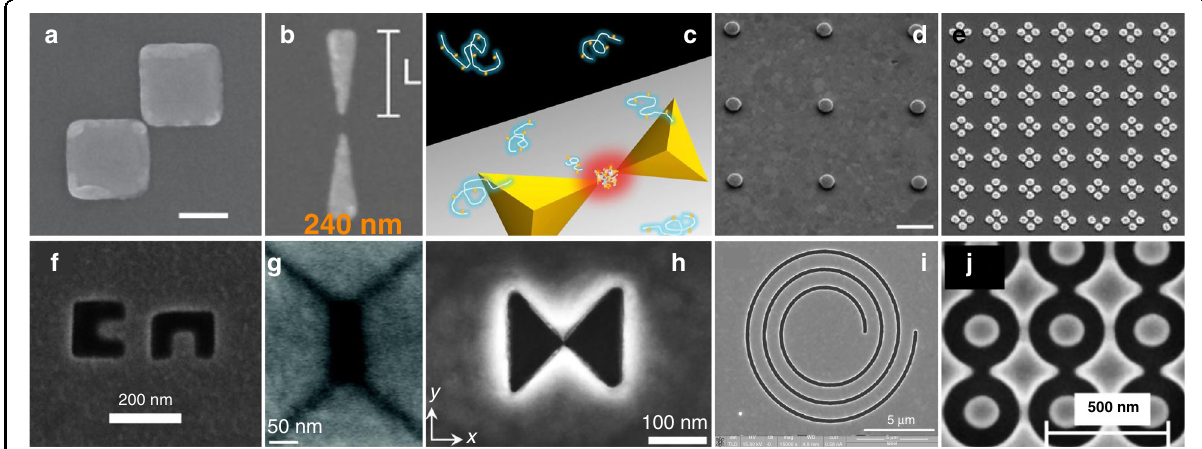
Fig. 6 Schematic diagram of plasmonic nanostructures. a – e Embossed patterns, and f – j hollow apertures. a Reproduced from ref. 170 ,